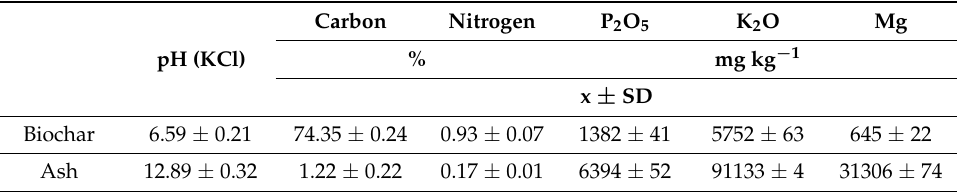
Table 1. pH value, contents of absorbable forms of macroelements and percentage content of carbon and nitrogen in biochar and ash from biomass. Table 2. Contents of water, ash and volatile substances in biochar and ash from biomass.